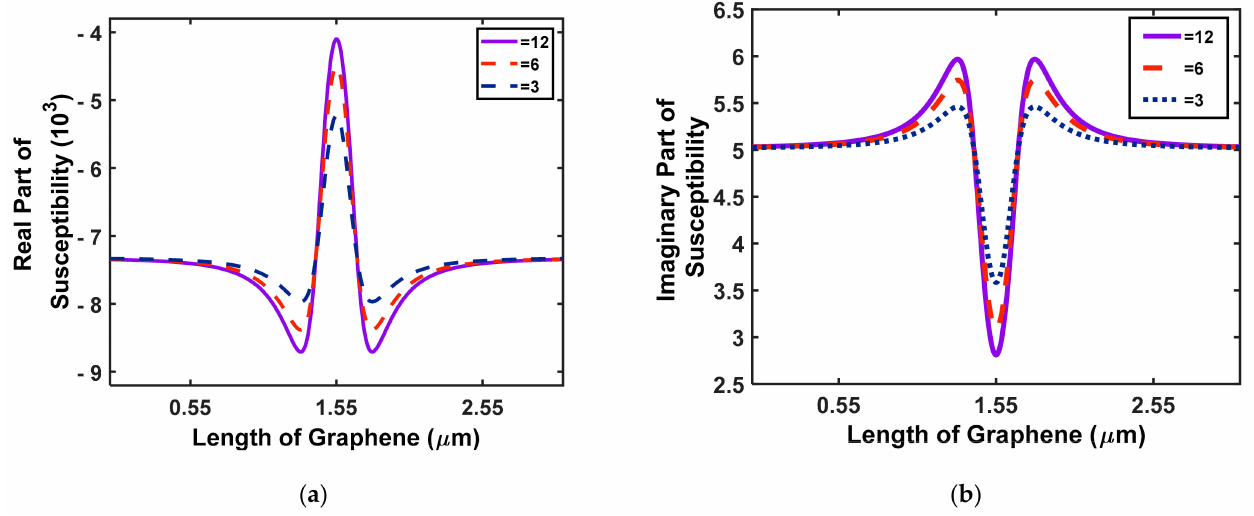
Figure 8. Effect of the permittivity of the quantum dot with radius 100 nm on ( a ) real and ( b ) imaginary parts of